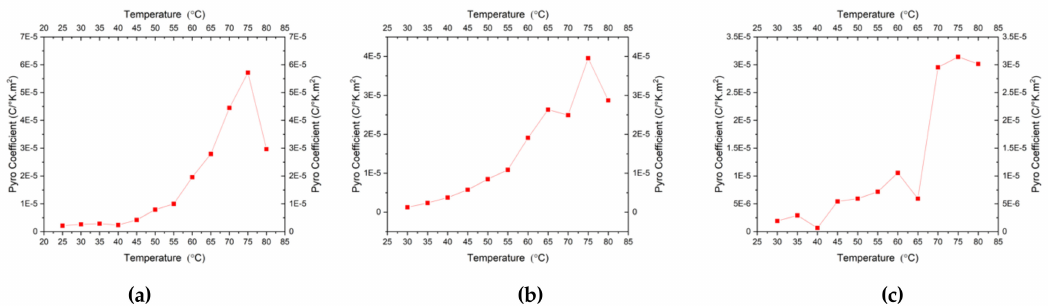
Figure 10. Variations of the Pyro-coe ffi cient of PCT samples deposited and annealed, respectively,